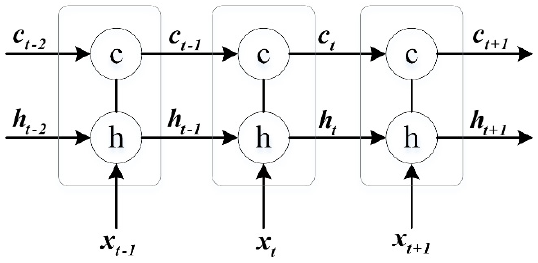
Figure 2. Network deployment structure of LSTM.